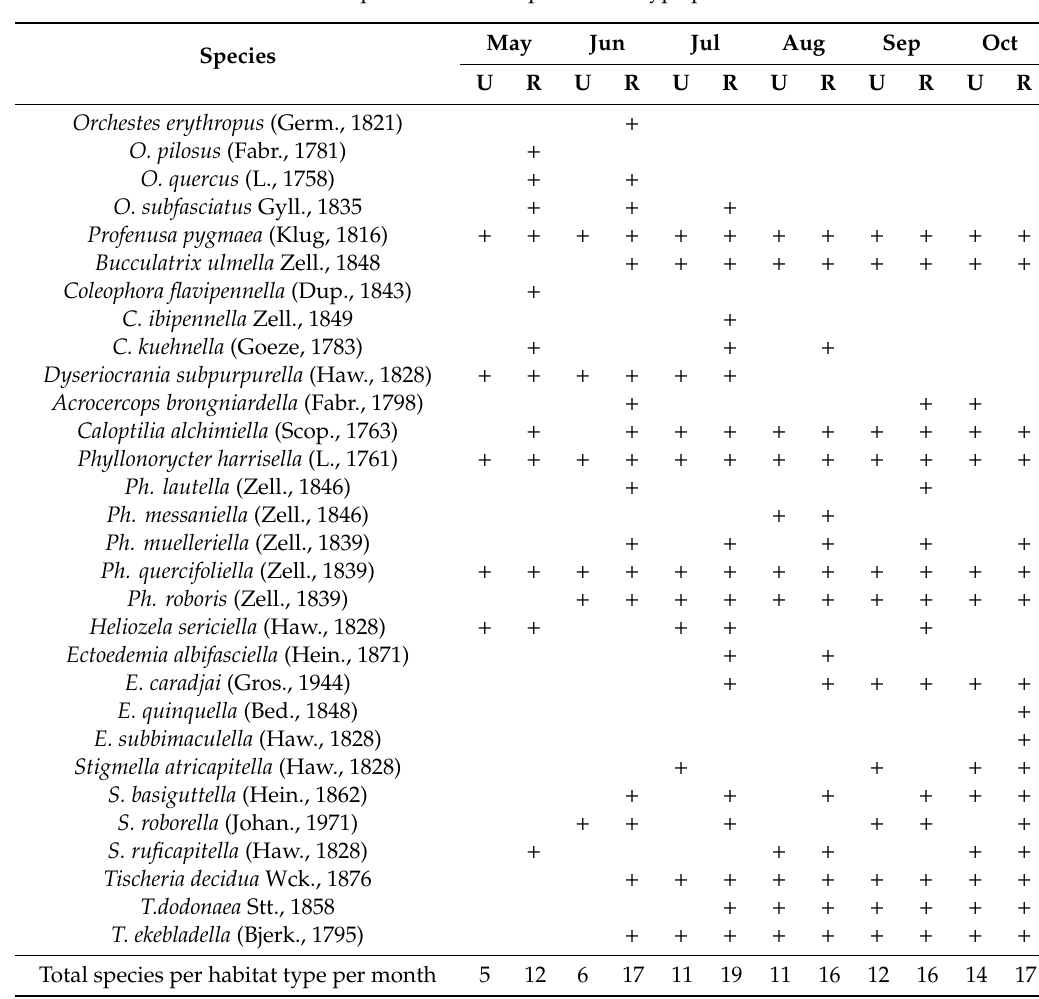
Table 5. Species identified per habitat type per month. Species